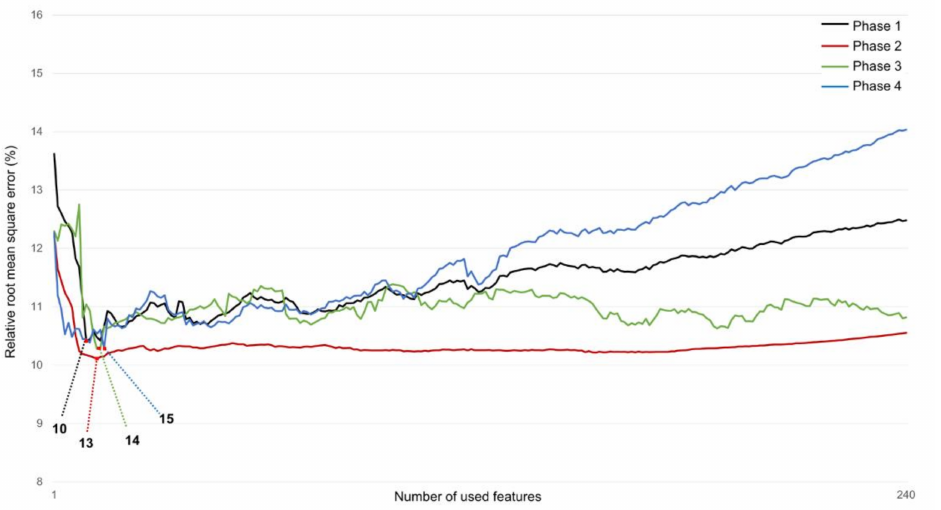
Figure 11. Relative root mean square error (%) computed during feature number optimization to use variables as input of Bi-LSTM network.